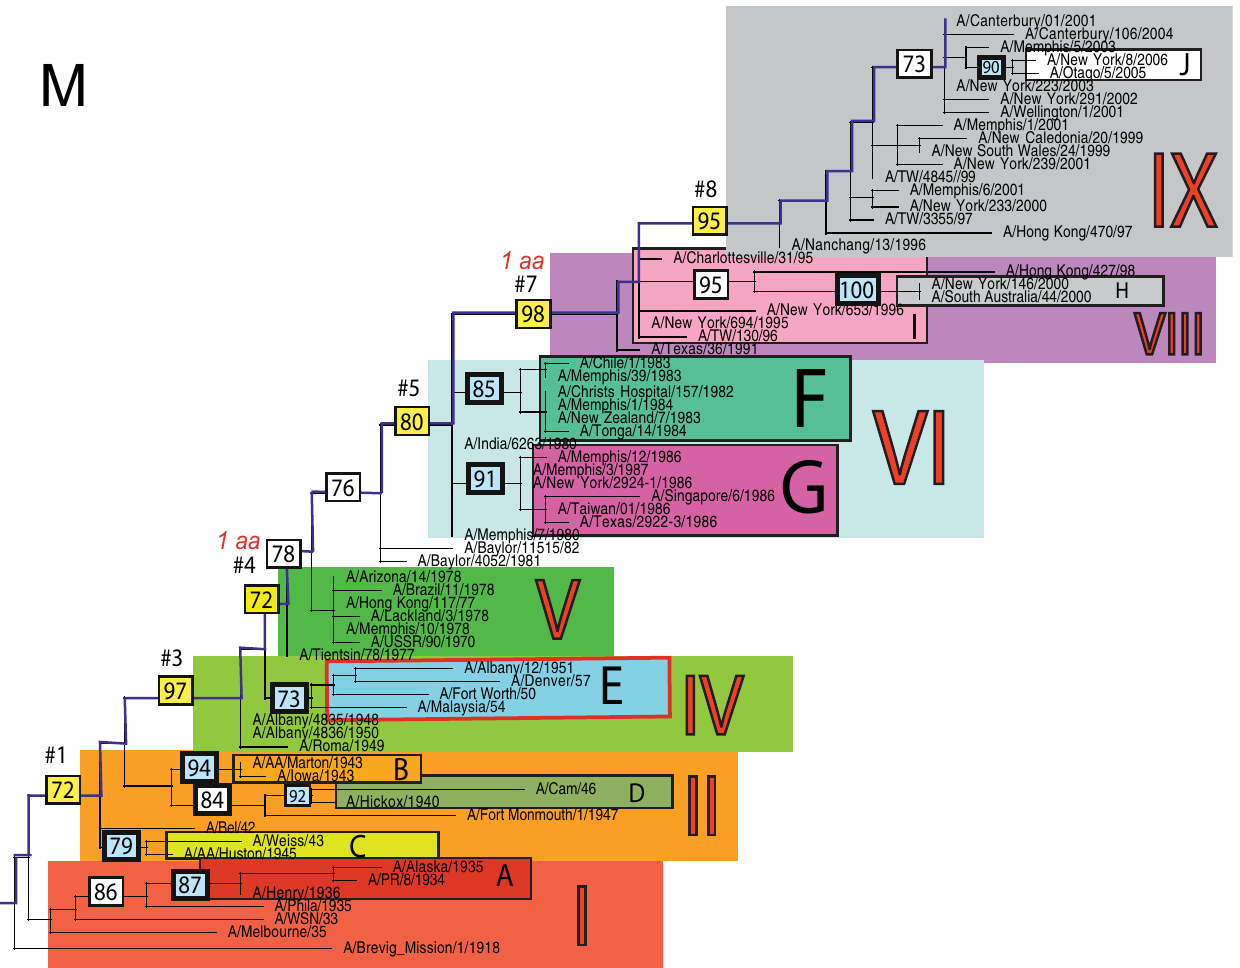
Figure 7. Phylogenetic relationships of the M1 gene of A/H1N1 influenza viruses (n=71) sampled globally from 1918–2006, estimated using ML. Rooting, scale, and color scheme are the same as those used in Figure